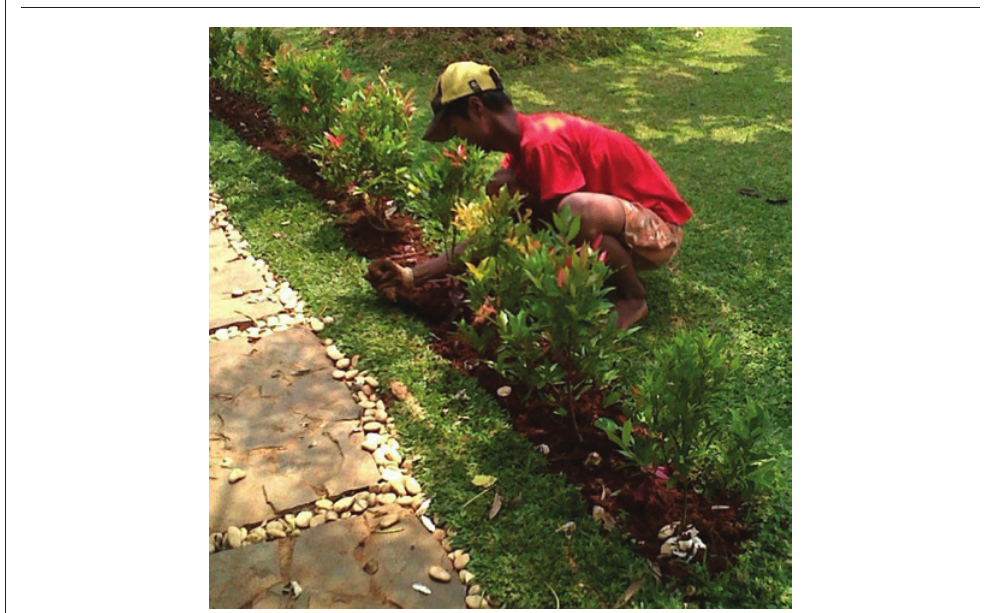
figure 5: Sekolah aman’s gardener at work (Source: elisabeth barratt Hacking, 2015) The children have spent their previous short lives begging or scavenging on the rubbish tips, toxic from the burning plastic. I met the gardener (see Figure 5), two teachers and a cook/helper, all from the local community; the gardener was also previously scavenging. Every day the school provides a meal of fresh local food, cooked in situ for the children and staff. The teacher is a former pupil of Sekolah Aman. Following a scholarship into secondary education he is now studying accountancy at night school and works here every